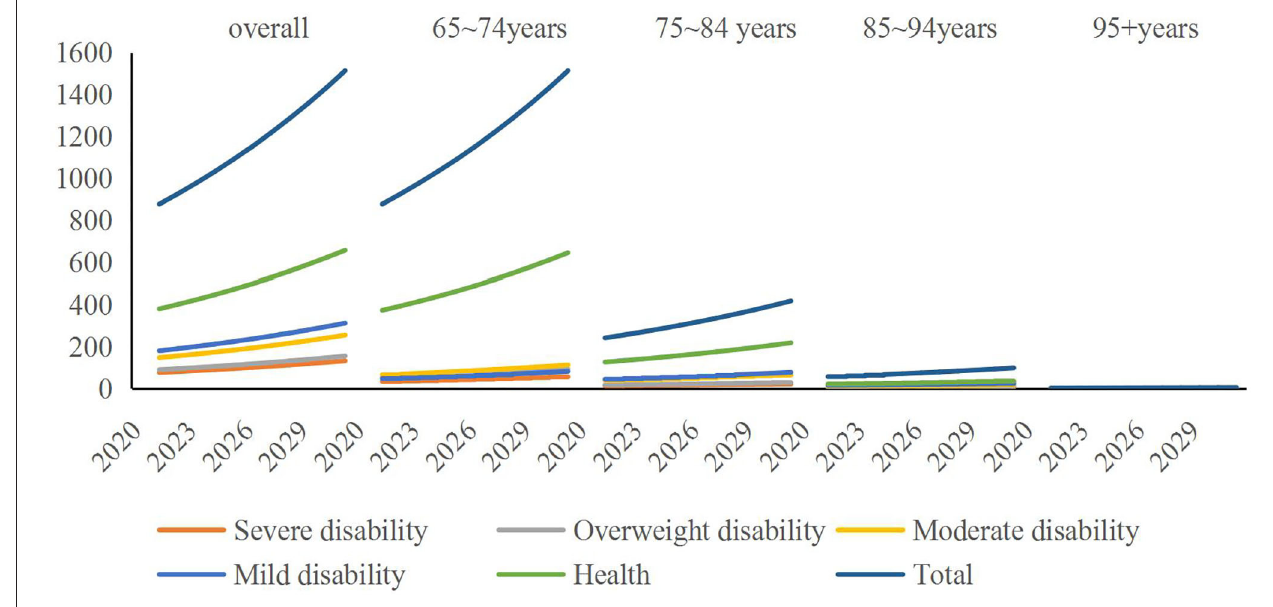
TABLE 4 | Duration of disability and average life expectancy by age group. Age Disabled state duration Average remaining